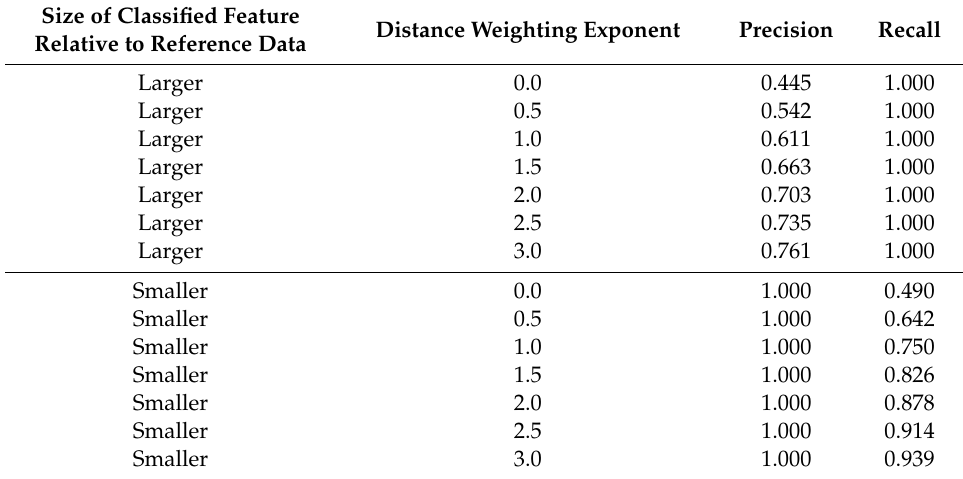
Table 4. Comparison of metrics generated using different distance weighting exponents. The “larger” classification scenario corresponds to the blue outlines in Figure 4; the “smaller” scenario corresponds to the circles shown using the yellow hash pattern. A distance weighting exponent of 0.0 represents the traditional (unweighted) method.